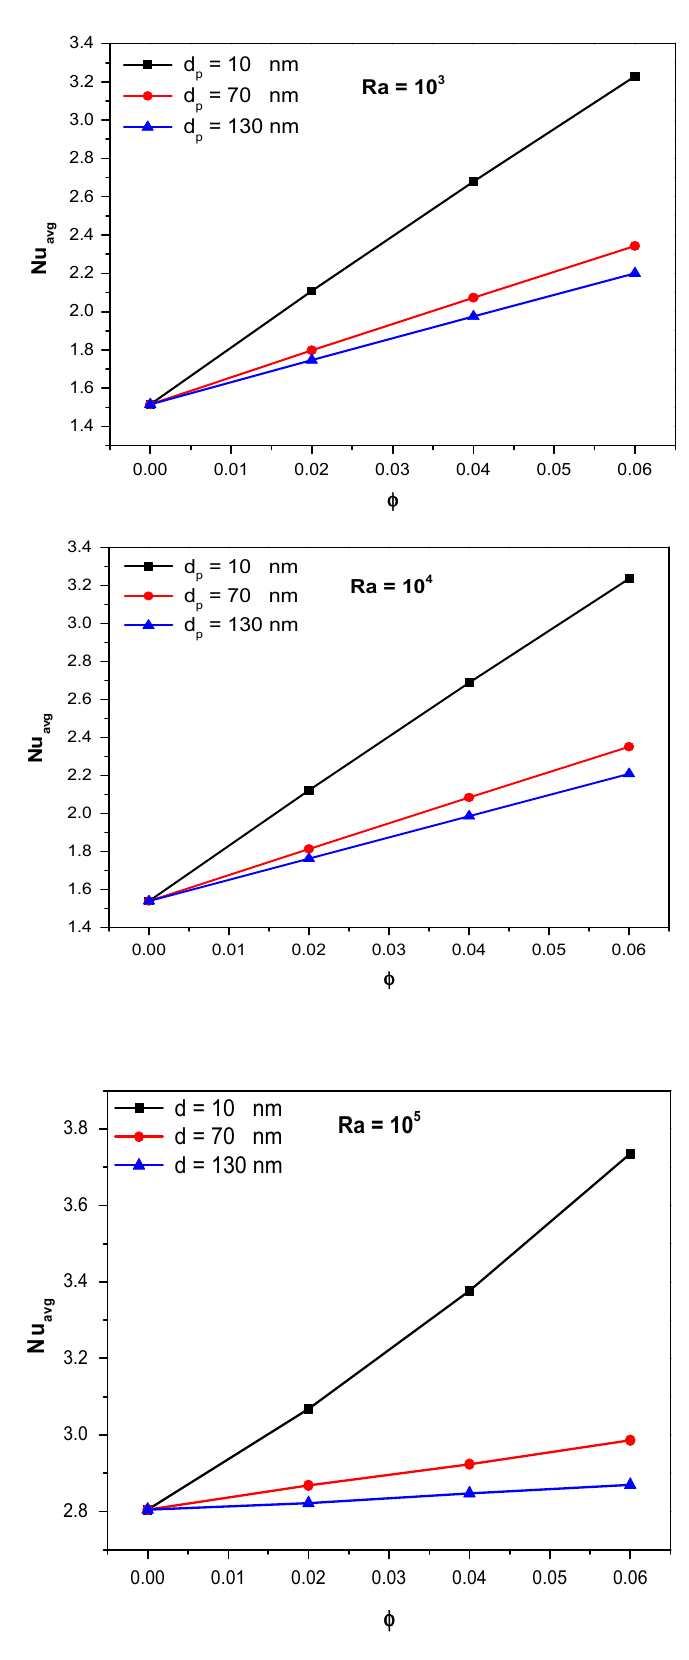
Figure 13. The variation between the average Nusselt number and the solid volume fraction for various values of the Rayleigh number and nanoparticle diameter at (Ha = 30).